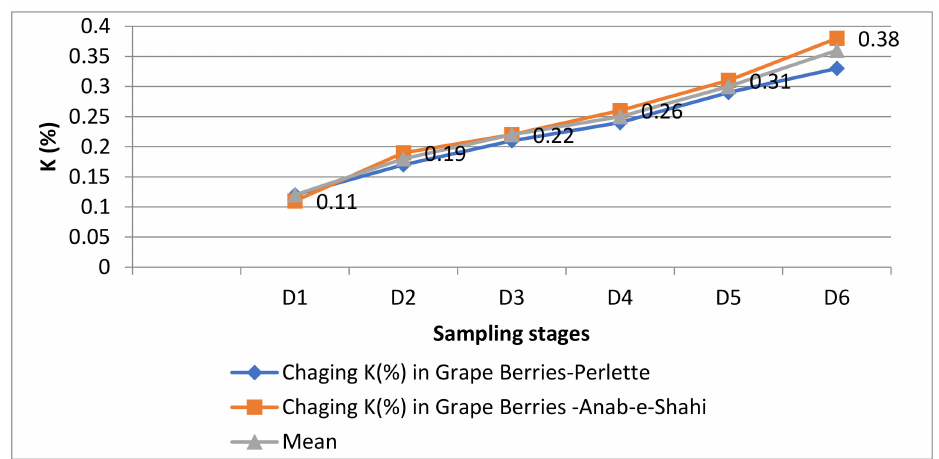
Figure 3. Chance of Potassium (%) concentration during the development of berries in grapes, cv. Perlette and